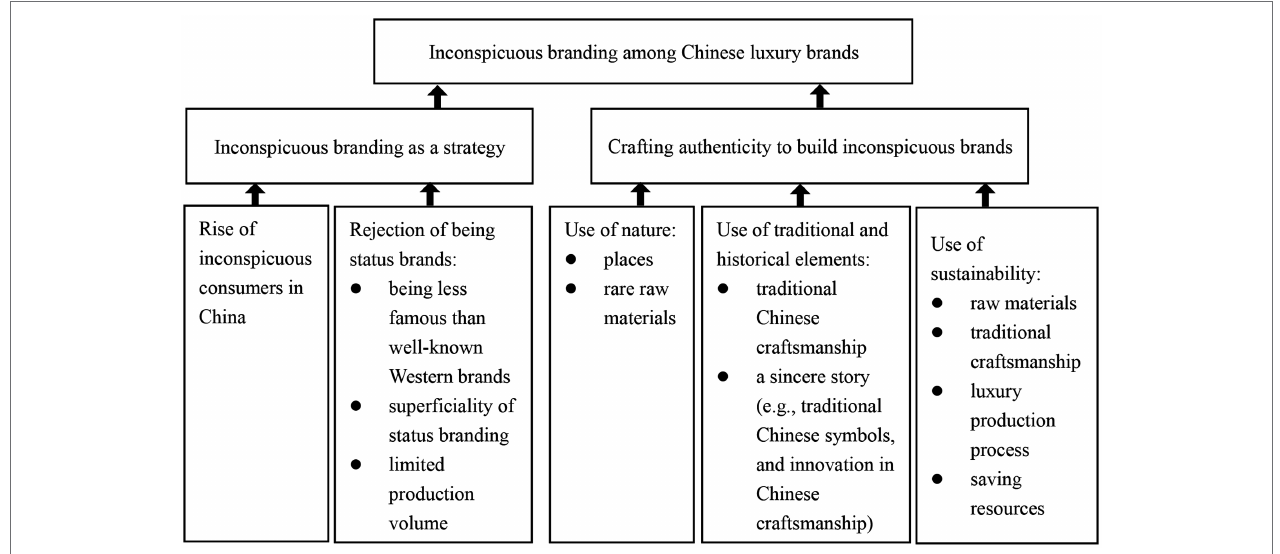
FIGURE 5 | Tangy Collection and Chou Tai Fook’s gold-casting